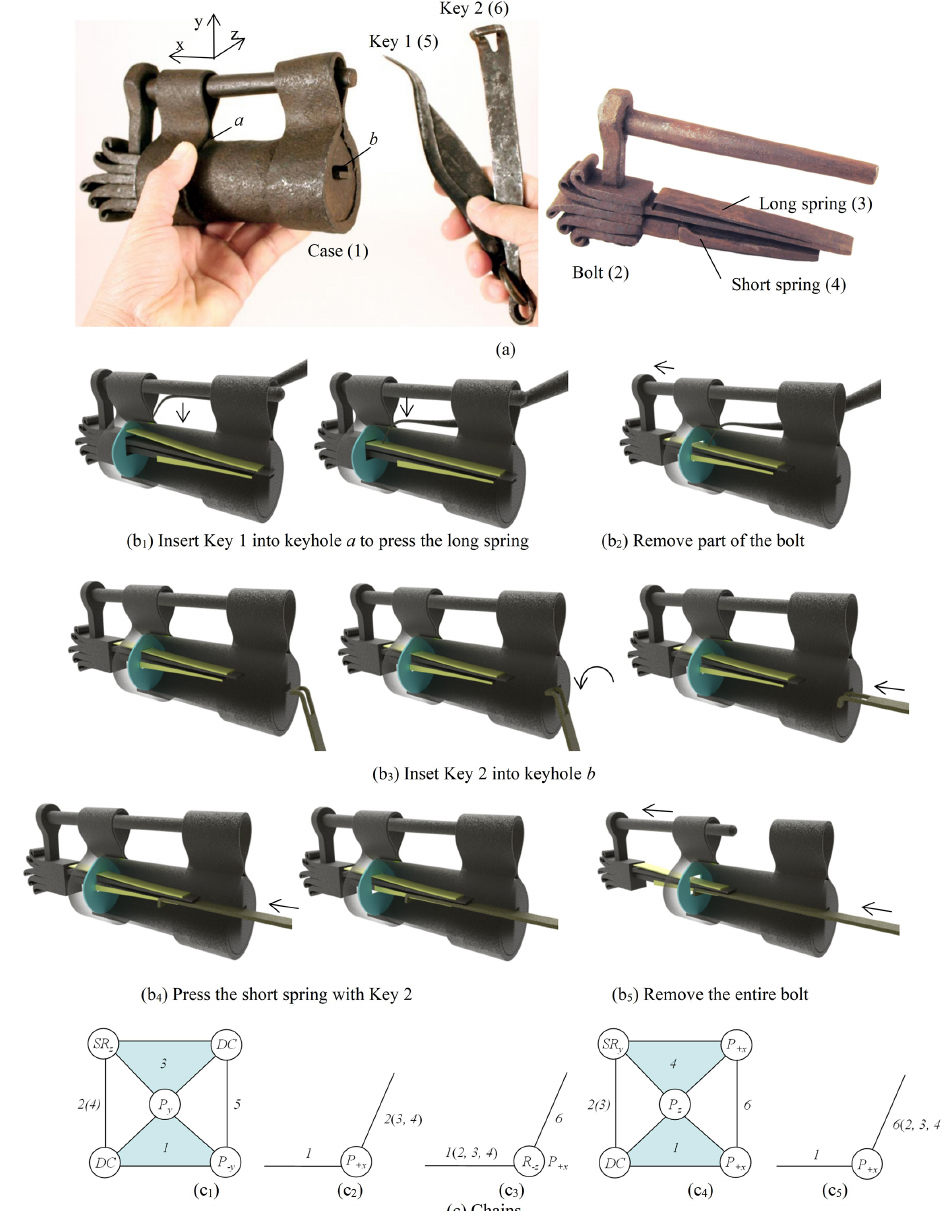
Figure 5. Iron padlock with poking hole – with two keys (Yi Zhi Tang